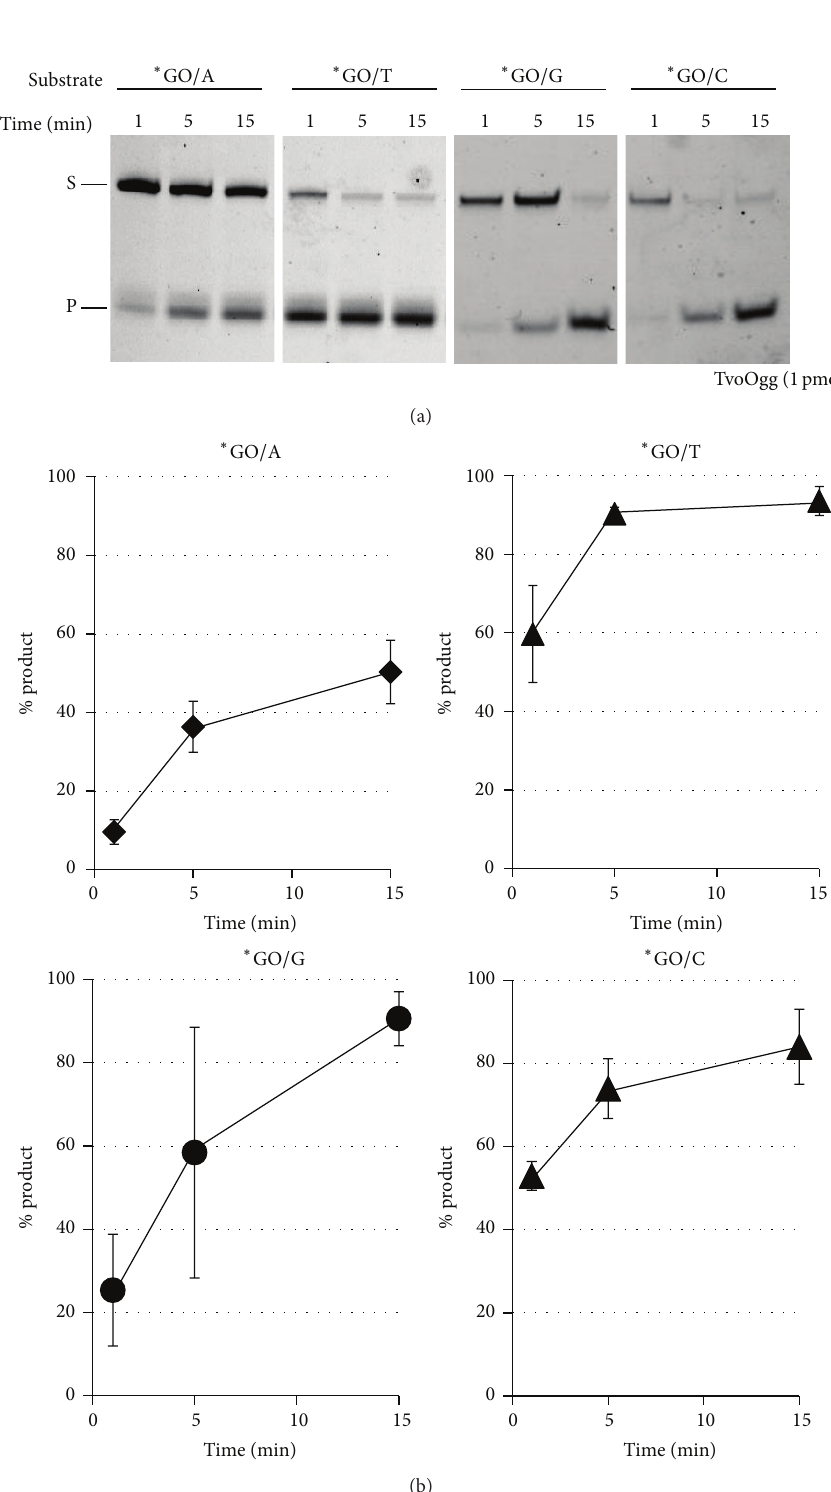
Figure 6: Time course of TvoOgg activity on substrates ∗ GO / A, ∗ GO / T, ∗ GO / G, and ∗ GO / C. One pmol of TvoOgg was incubated with heteroduplex DNA containing ∗ GO / A, ∗ GO / T, ∗ GO / G, and ∗ GO / C mismatches at 60 ∘ C. At the indicated time points, the reaction was quenched with 4 𝜇 L of 1M NaOH to inactivate enzyme and cleave resulting AP sites. The uncut 34-mer DNA substrates (S) and cleaved 13-mer products (P) are indicated on the left. Asterisks indicate 5 󸀠 -FAM-labeled strand. Each data point is represented as the mean ± SD of three independent